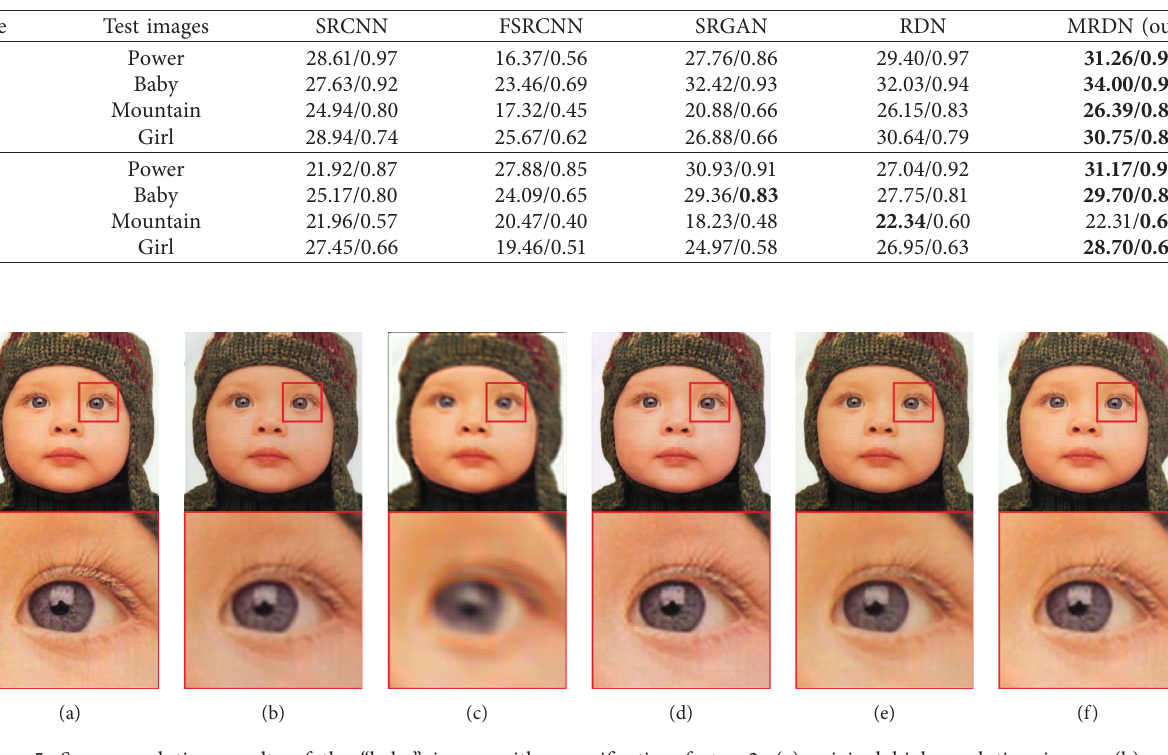
Figure 5: Super-resolution results of the “baby” image with magnification factor 2: (a) original high-resolution image; (b) result reconstructed by SRCNN; (c) result reconstructed by FSRCNN; (d) result reconstructed by SRGAN; (e) result reconstructed by RDN; (f) result reconstructed by our